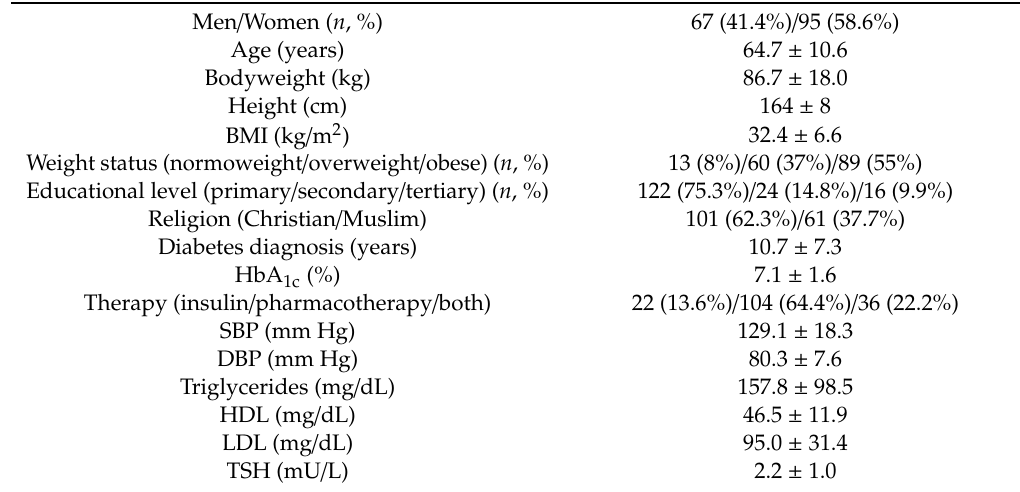
Table 1. Patient characteristics ( n and %, or mean ± SD) ( n =